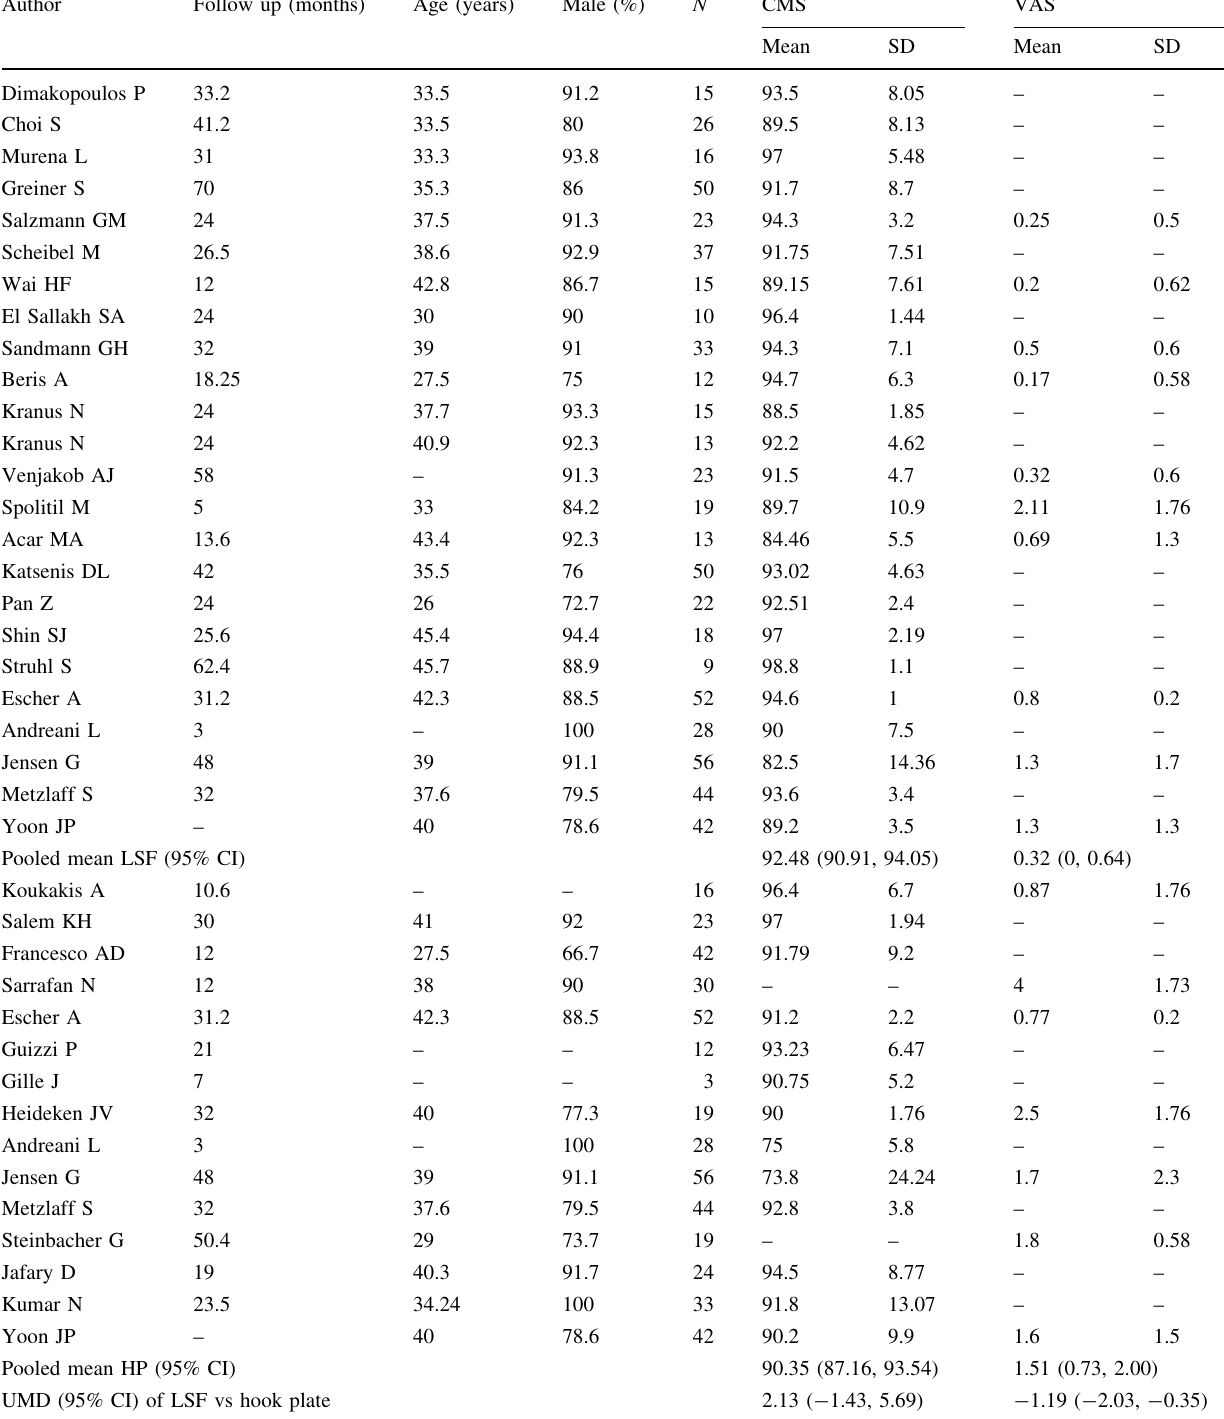
Table 2 Estimation of the pooled mean of CMS and VAS pain of loop suspensory fixation (LSF) and HP